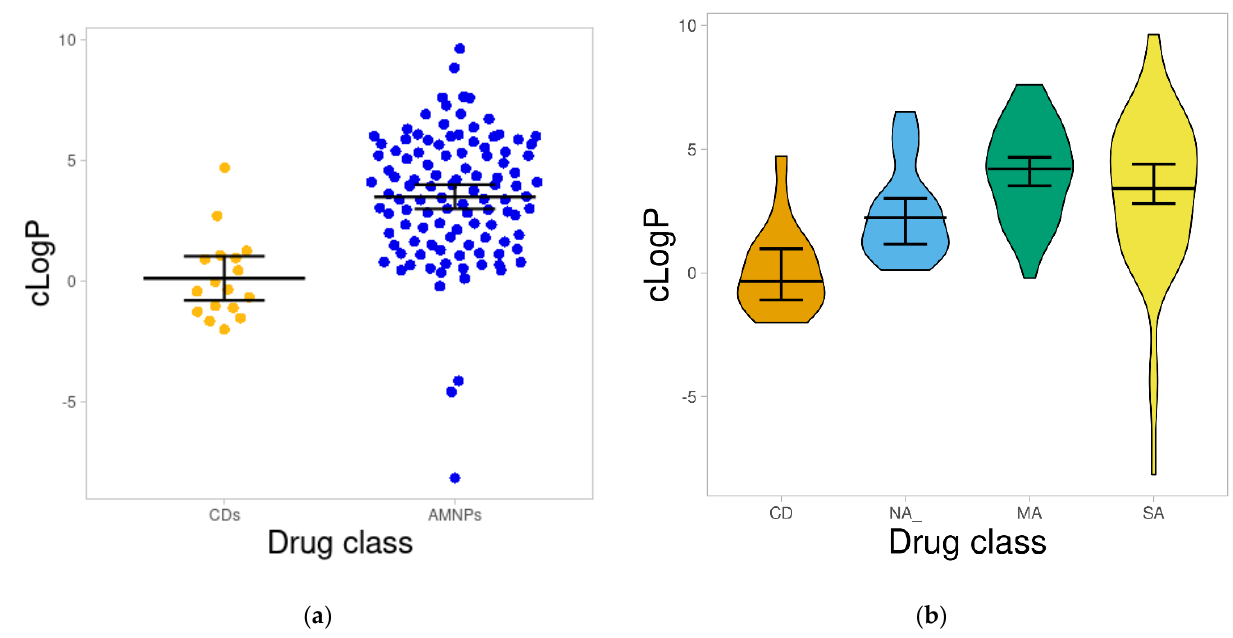
Figure 2. Distribution of cLogP for the datasets. ( a ) is a swarm plot showing the cLogP of AMNPs and CDs. ( b ) shows a violin plot of the various categories of AMNPs and CDs where the boxes indicate the distribution of each of the datasets; the line that divides the boxes represents the median of the distributions. The average cLogP for all the categories of the AMNPs is significantly higher ( p < 0.05) than that of the CDs. The black bars in both figures indicate a 95% confidence interval.